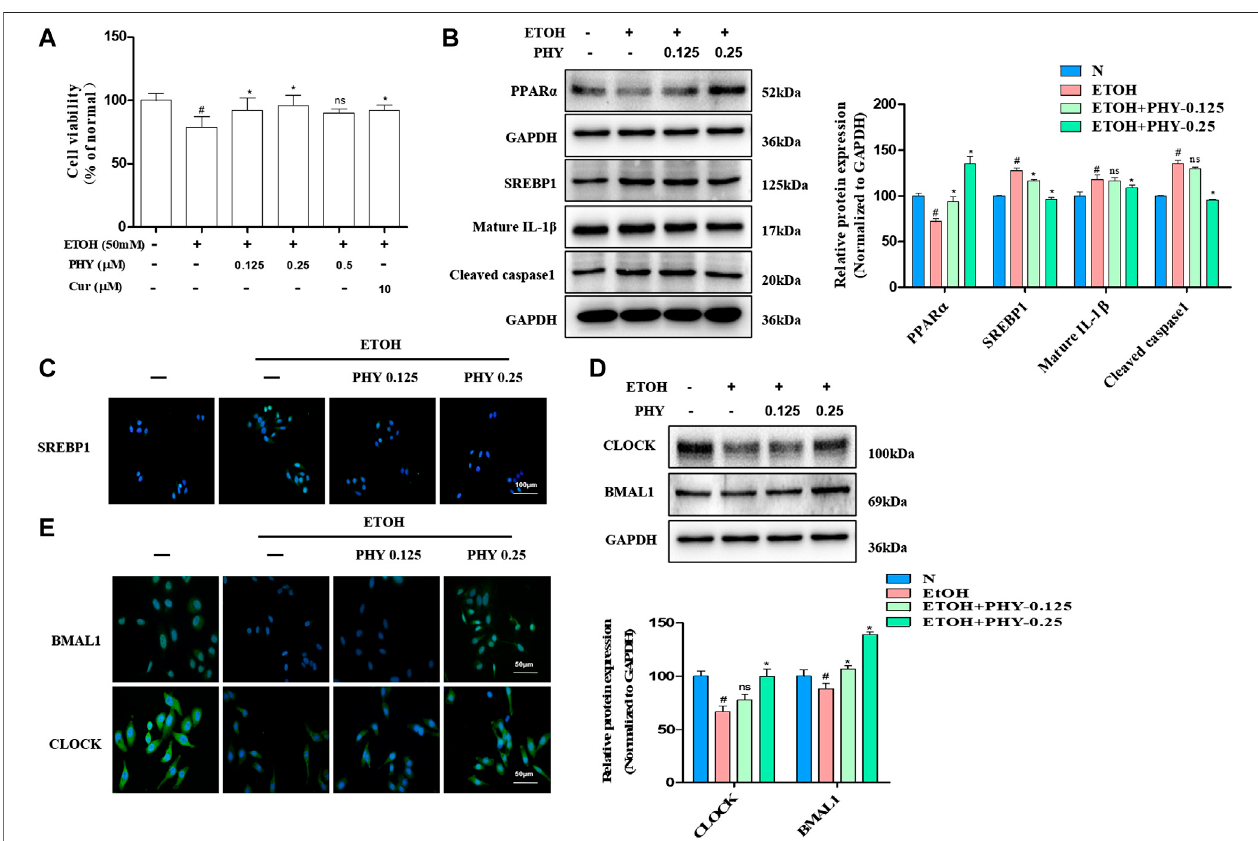
FIGURE 5 | Physcion improves increased in fl ammasome activation and ameliorates lipid accumulation in HepG2 cells. (A) Cell viability was determined by MTT assay. (B) The protein expression of PPAR α , SREBP1, IL1 β , and caspase1. (C) Immuno fl uorescence staining of SREBP1. (D) The protein expression of BMAL1 and CLOCK. (E) Immuno fl uorescence staining of BMAL1 and CLOCK. Values signi fi cantly different from the control are indicated by hash signs ( # p < 0.05). Values signi fi cantly different from the ethanol are indicated by asterisks (* p < 0.05).